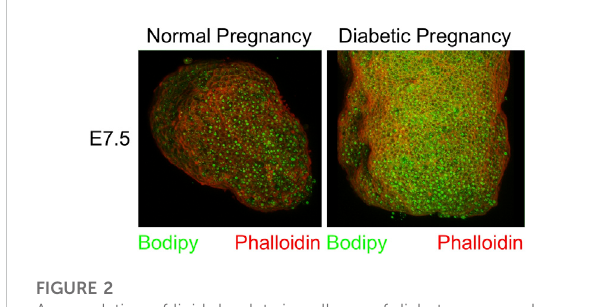
FIGURE 2 Accumulation of lipid droplets in yolk sac of diabetes-exposed embryos. Conceptuses were isolated from normoglycemic and diabetic pregnant NOD dams at gestational day E7.5, and dissected freeoftheparietalyolksac.TheywerestainedwithPhalloidinand Bodipy. The conceptus from a diabetic pregnancy displays more lipid droplets in the visceral yolk